Question: What visual encoding does this figure use to show its data?
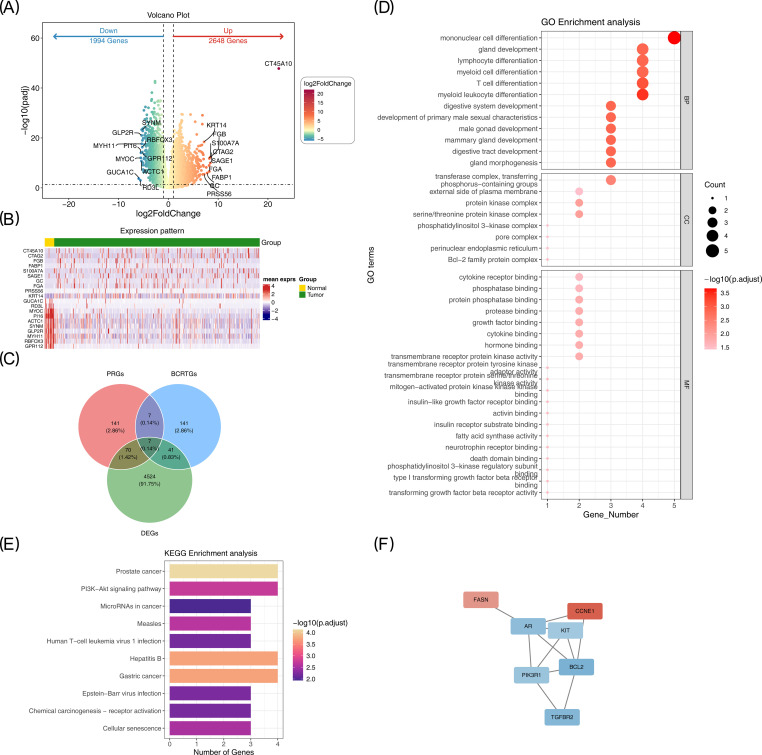
Answer: heatmap